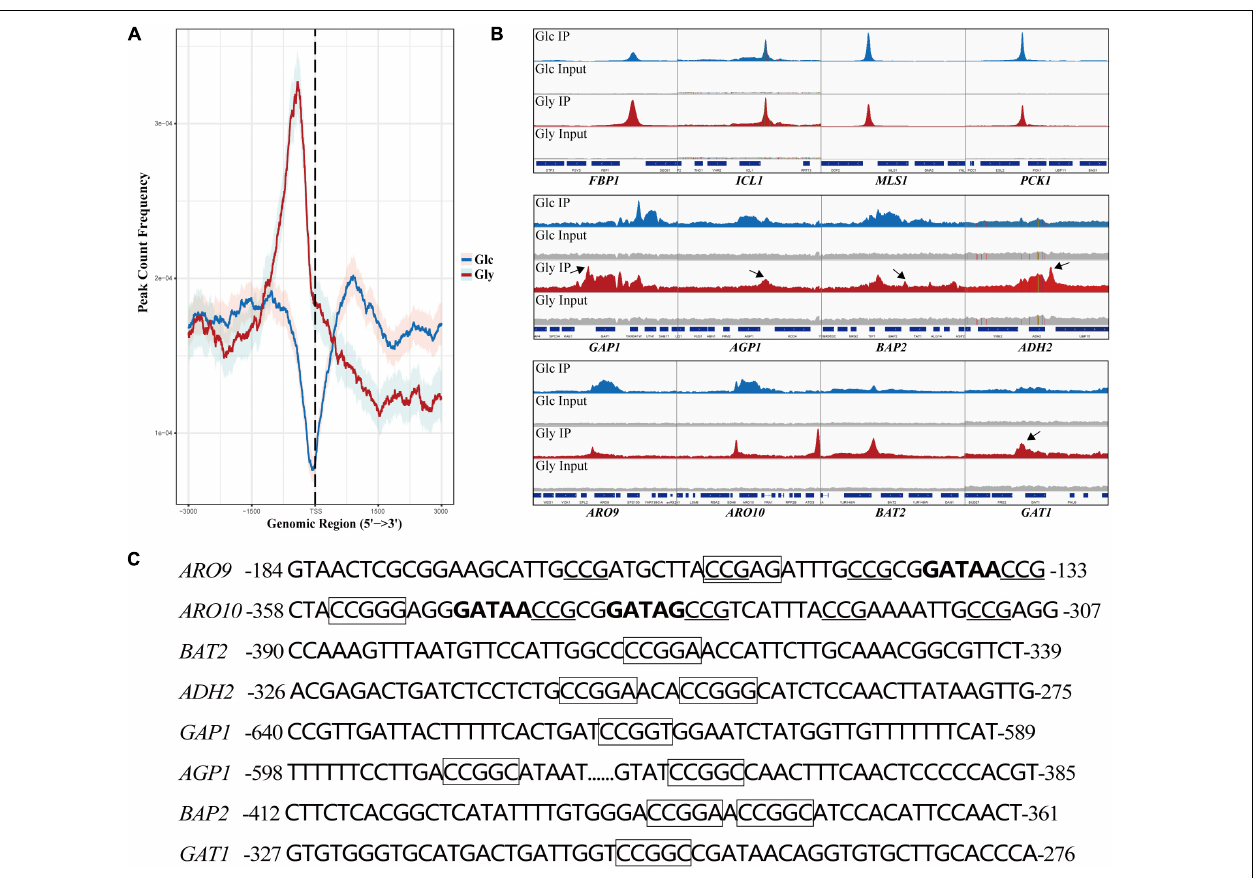
FIGURE 4 | Analysis of binding peaks of transcription factor Cat8 under two carbon sources by ChIP-seq. (A) The distribution of reads in the peak region (3,000 bp upstream and downstream of TSS) on all transcripts under the glucose (Glc) or glycerol (Gly) condition was calculated to reflect the binding intensity of Cat8 to DNA at 0.95 confidence interval. (B) IGV examined the peaks enriched by ChIP-seq. The blue and red peaks represented the binding peaks of Cat8 under the conditions of Glc and Gly, respectively, and the gray was input. (C) Promoter sequences of Cat8 target genes include ARO9 , ARO10 , BAT2 , ADH2 , GAP1 , AGP1 , BAP2 , and GAT1 . Cat8 binding sites (CCGGN) were marked with a box. CCG triplets, the binding site of Aro80, were underlined, and GATA factor binding sites (GATAA/G) were indicated in